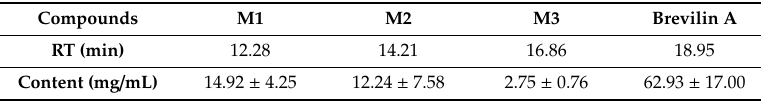
Table 3. LC-Q-TOF in the positive ion mode of CMX.